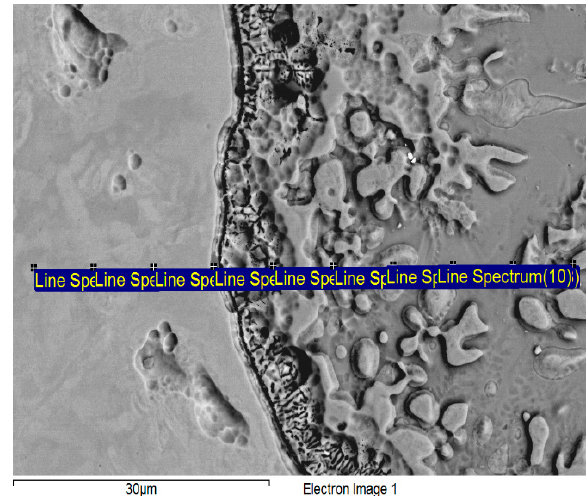
Figure 8. Measurement of chemical composition by EDS analysis (weld 8).